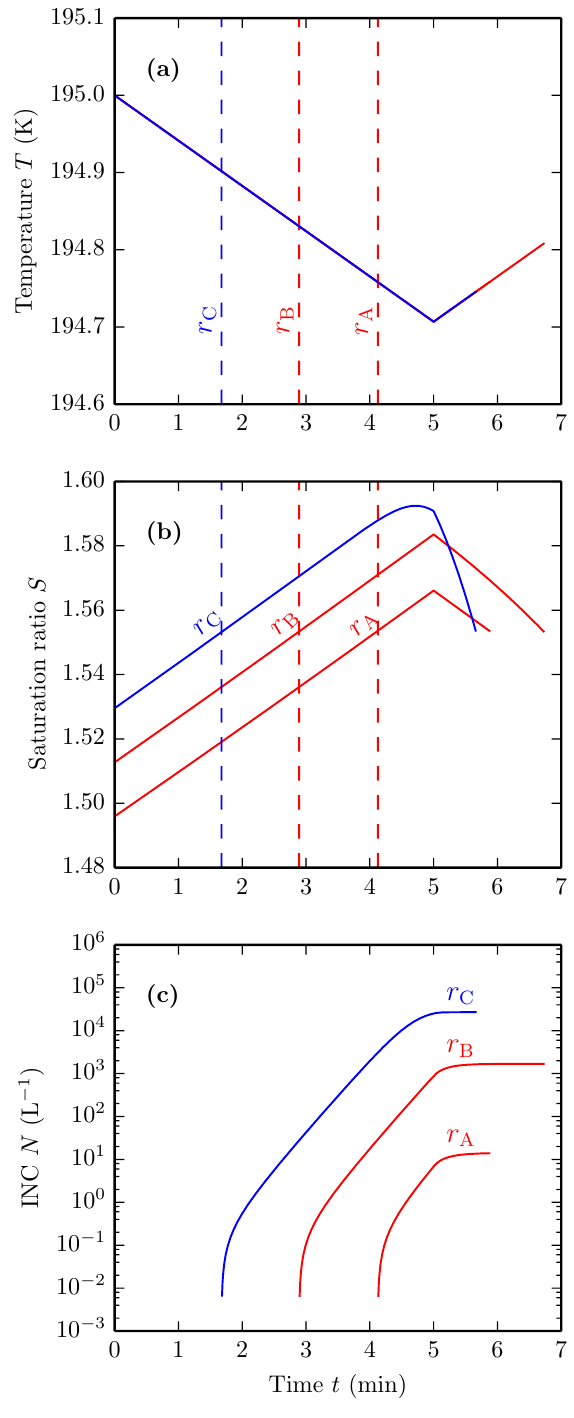
Figure 10. Evolution of temperature (a) , saturation ratio (b) , and INC (c) for three air parcels with slightly different ini- tial water vapour mixing ratios: { r A = 1 . 78; r B = 1 . 80; r C = 1 . 82 }× 10 − 5 kgkg − 1 . The parcels follow the same temperature time series as shown in (a) , but they begin nucleation at different times (indicated by the dash lines) and end up with widely different INCs.